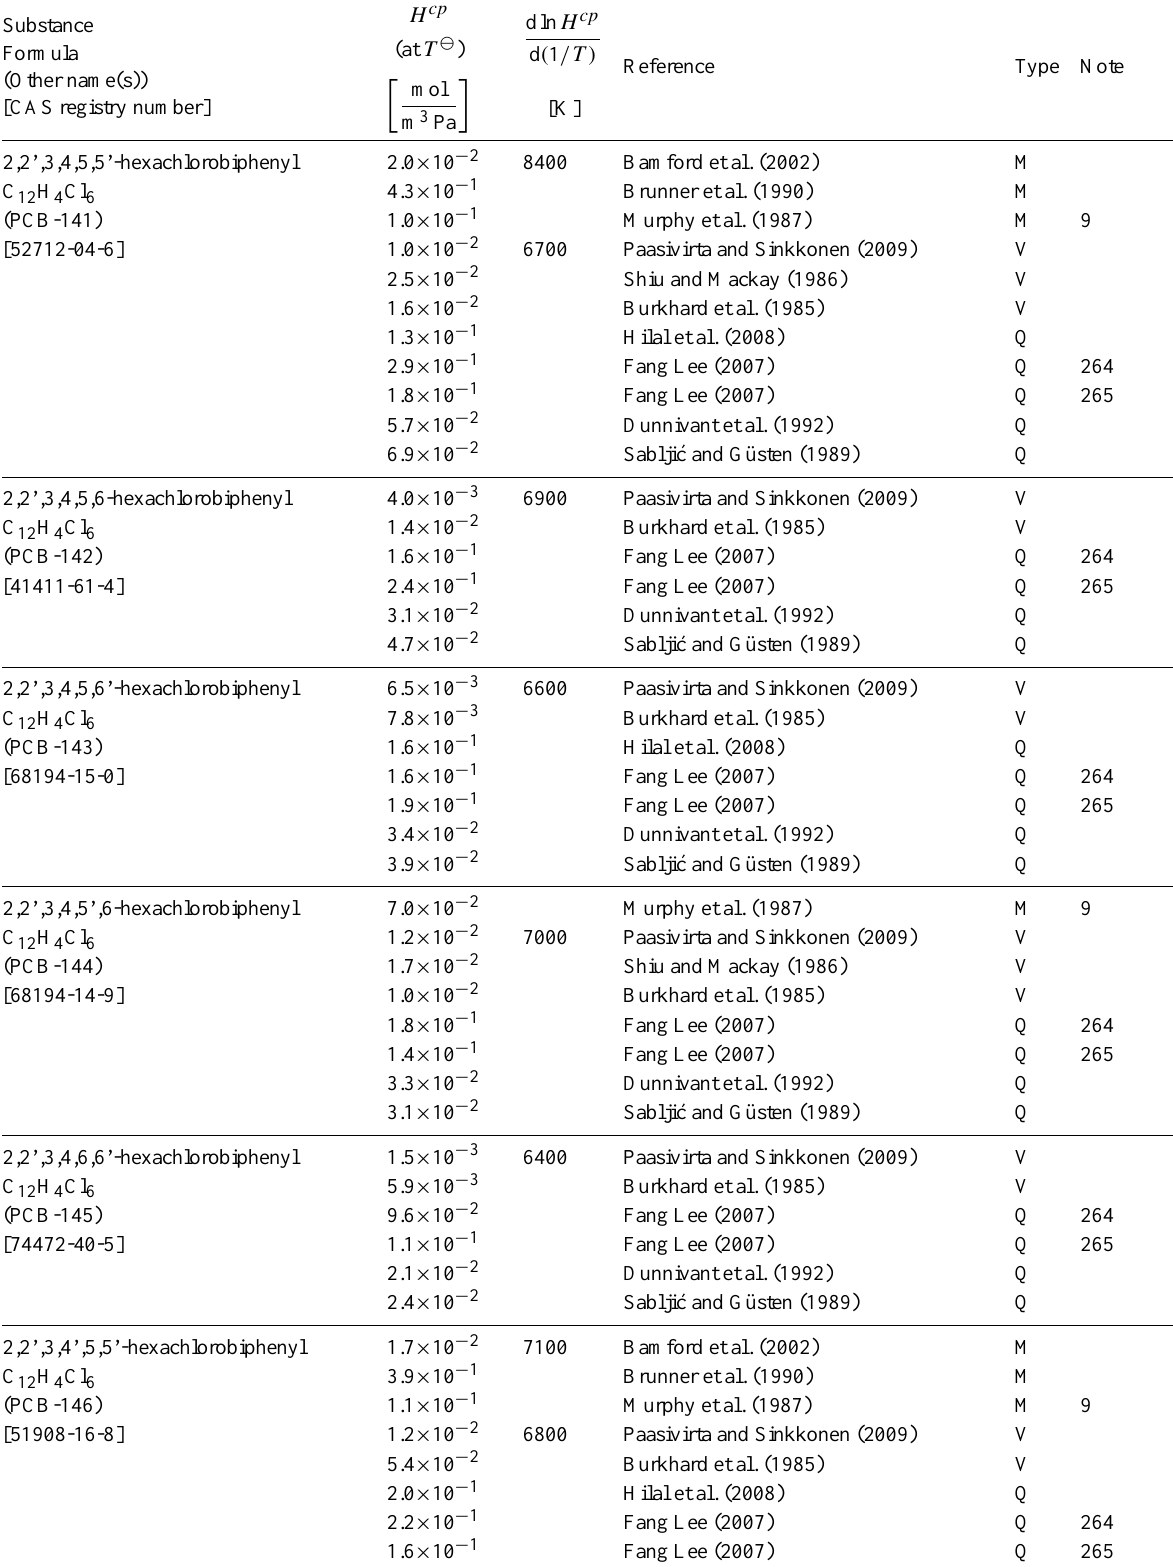
Table 6: Henry’s law constants for water as solvent